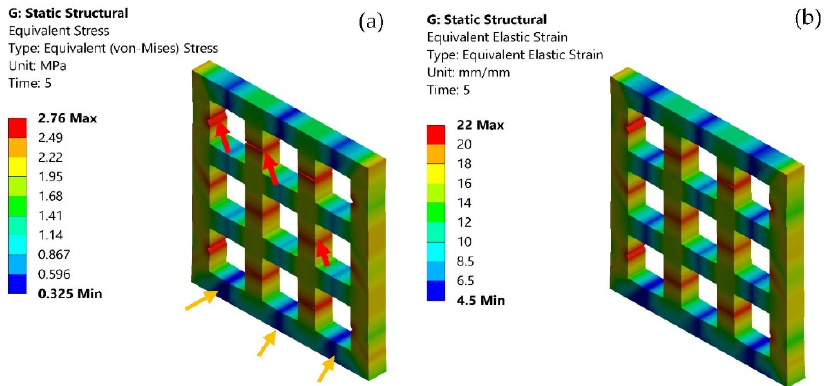
Figure 4. ( a ) von Mises stress distribution on the scaffold model; maximum stress (red arrows), minimum stress (yellow arrows); and ( b ) elastic strain on the scaffold model.